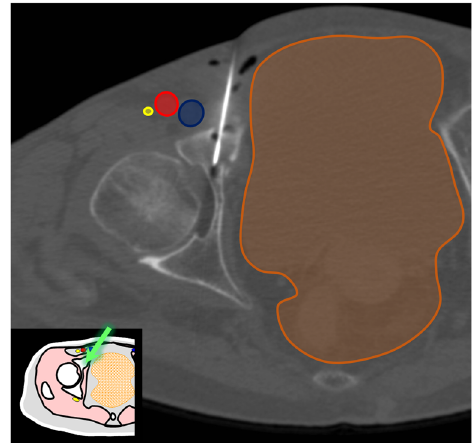
Fig. 15 A 69-year-old woman with clinical background of lung cancer presenting with painful pathological fracture of the superior pubic ramus. An anterior approach medial to the femoral vessels was used to perform cementoplasty through an 18-G spinal needle